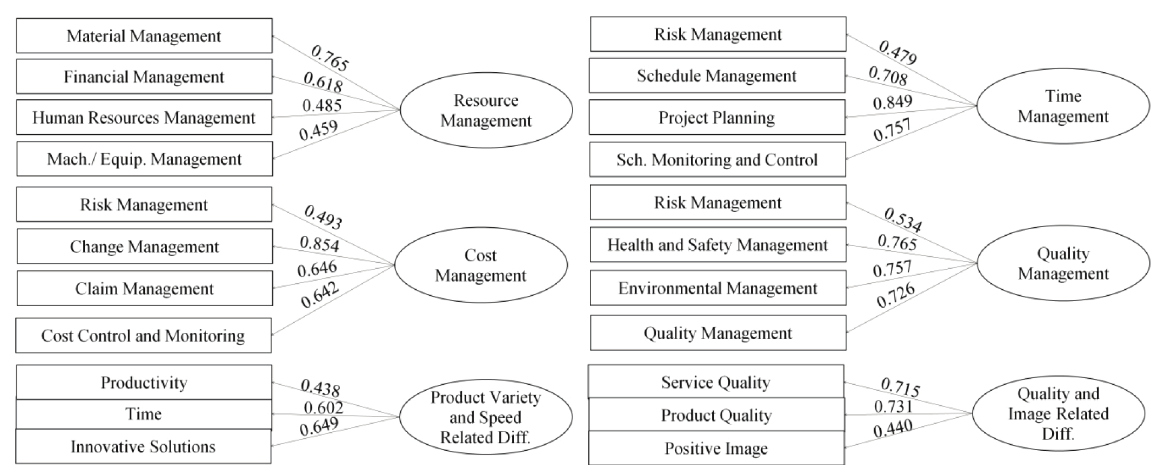
Fig. 3. Factor loadings of the exogenous and endogenous latent